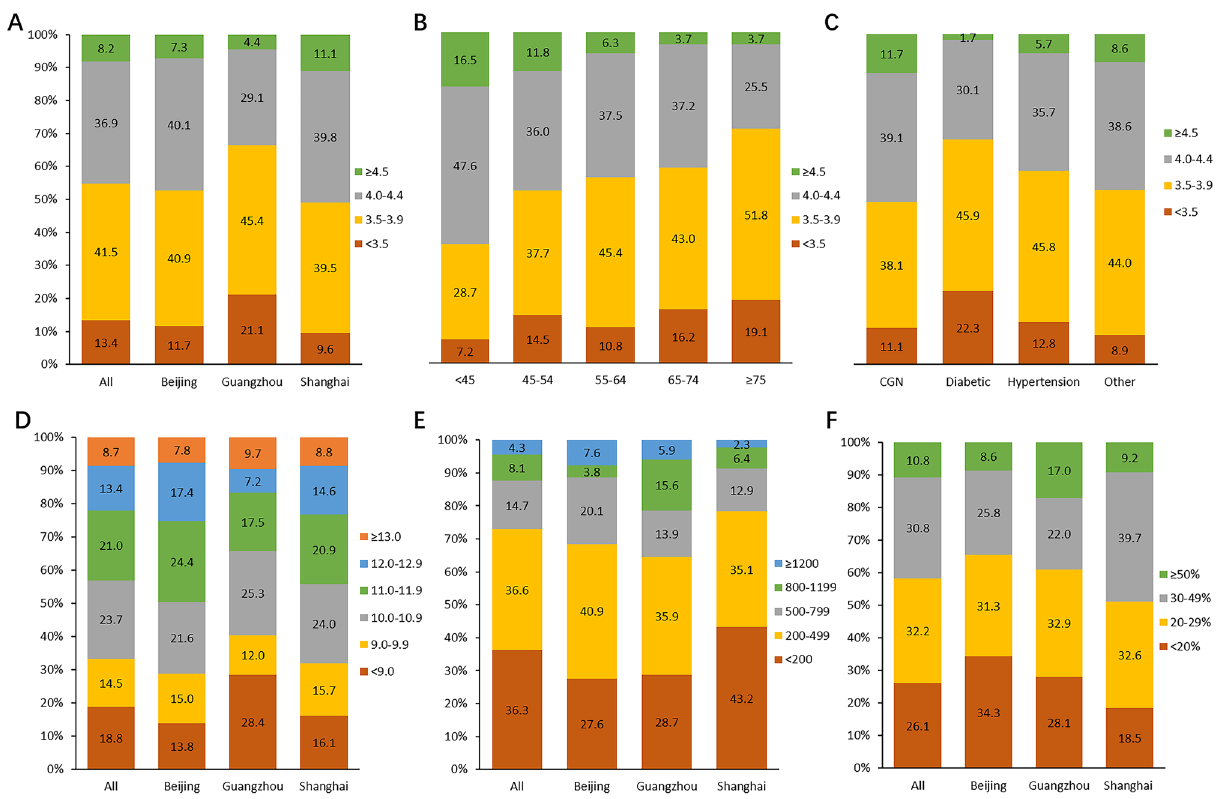
Figure 2. The distribution of ALB, Hgb, ferritin and TSAT. ( A ) The distribution of serum ALB level stratified by city group; ( B ) the distribution of serum ALB level stratified by age group; ( C ) the distribution of serum ALB level stratified by the primary ESKD causes group; ( D ) the distribution of serum Hgb level stratified by city group; ( E ) the distribution of serum ferritin level stratified by city group; ( F ) the distribution of TSAT stratified by city and gender